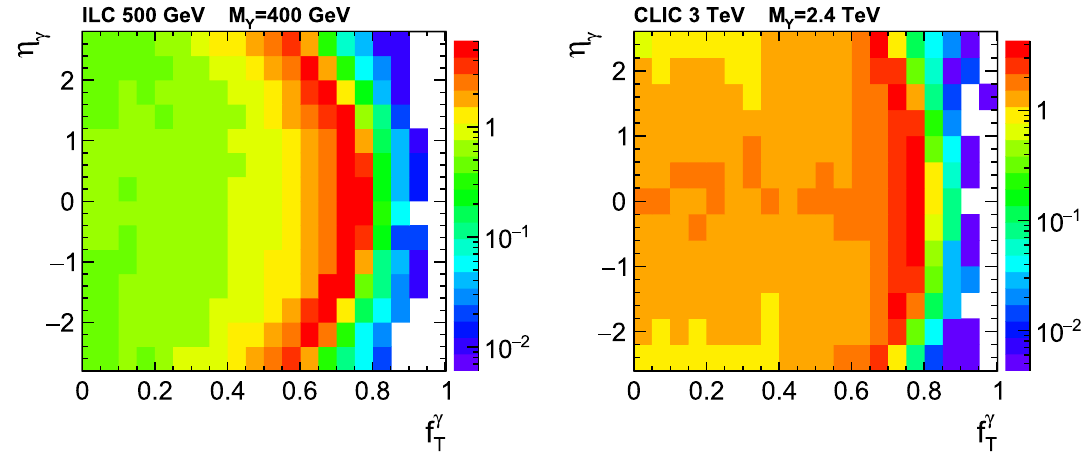
Fig. 8 Pseudorapidity vs transverse momentum fraction for mono-photon signal events at 500GeV ILC (left) and 3TeV CLIC (right). Pair- production of fermion DM particles with m χ = 50GeV is considered for mediator mass M Y = 400GeV at 500GeV ILC running with − 80%/+30% electron/positronbeampolarisation(left)andfor M Y =2.4TeVat3TeVCLICrunningwith–80%electronbeampolarisationonly(right).Simplified DM model predictions are calculated for the relative mediator width of (cid:4)/ M = 0 . 03 and normalised to the unpolarised DM production cross section of